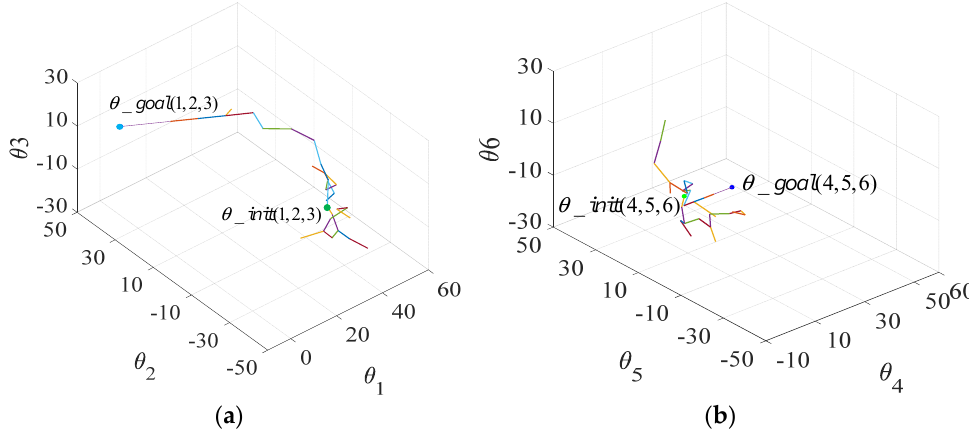
Figure 9. Exploration process of the main arm joint angle: ( a ) the first three joint angles of the main arm; ( b ) the posterior three joint angles of the main arm.